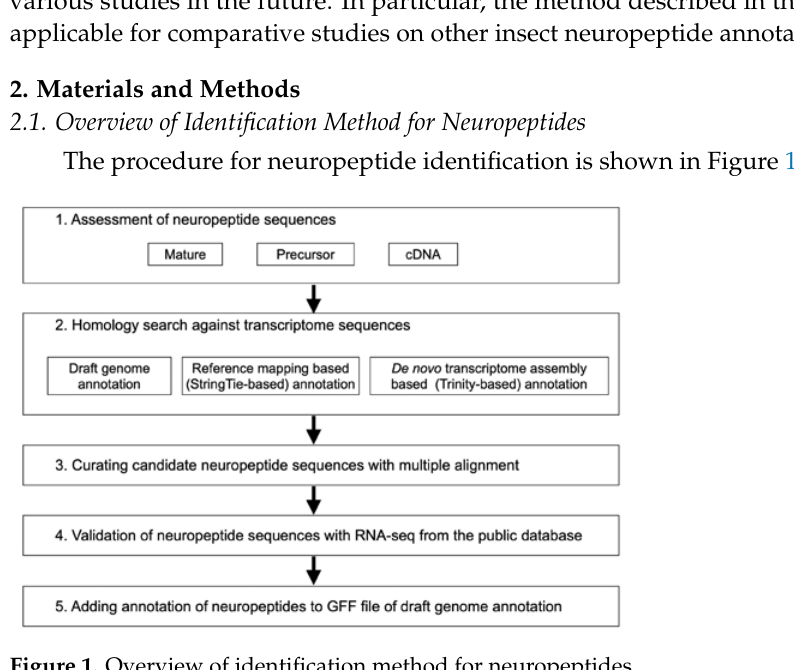
Figure 1. Overview of identification method for neuropeptides.